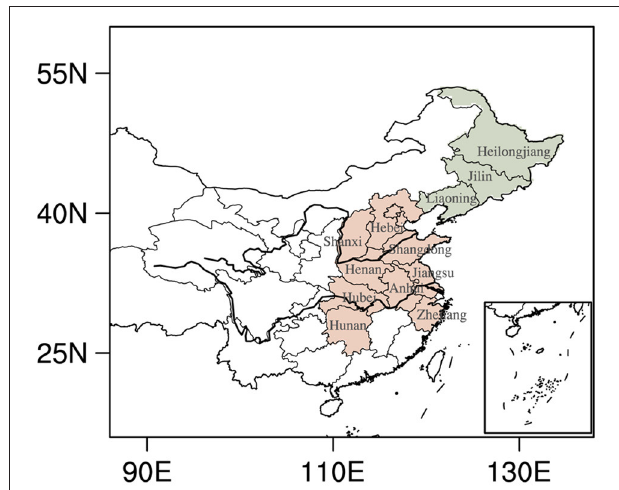
FIGURE 1 | The research domain. The region with green color denotes the northeast China, and the region with red color is Central and East